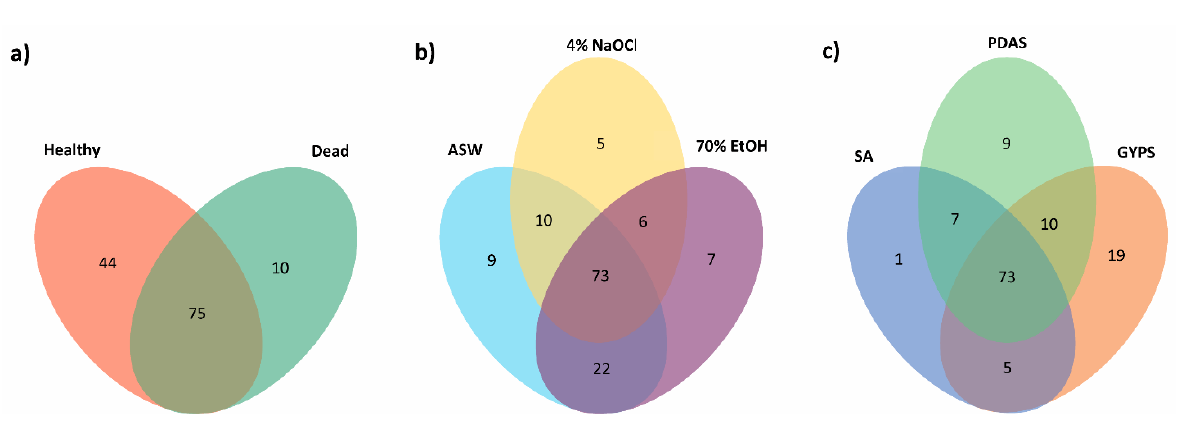
Figure 6. Venn diagrams showing fungal species richness ( a ) in healthy and dead thalli, ( b ) in thalli under different sterilization regimes (artificial seawater (ASW), 70% ethanol (70% EtOH), and 4% sodium hypochlorite (4% NaOCl)), and ( c ) in thalli isolated on different media (seawater agar (SA), glucose-yeast extract-peptone seawater agar (GYPS), and potato dextrose seawater agar (PDAS)).